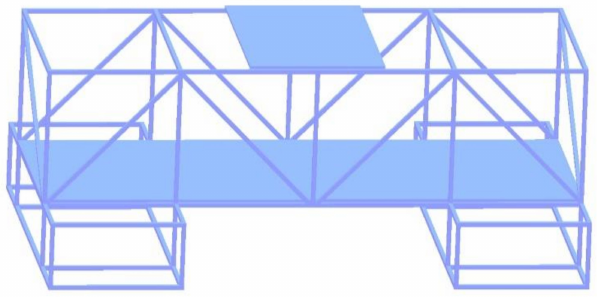
Figure 8. Numerical calculation model of composite steel structure.